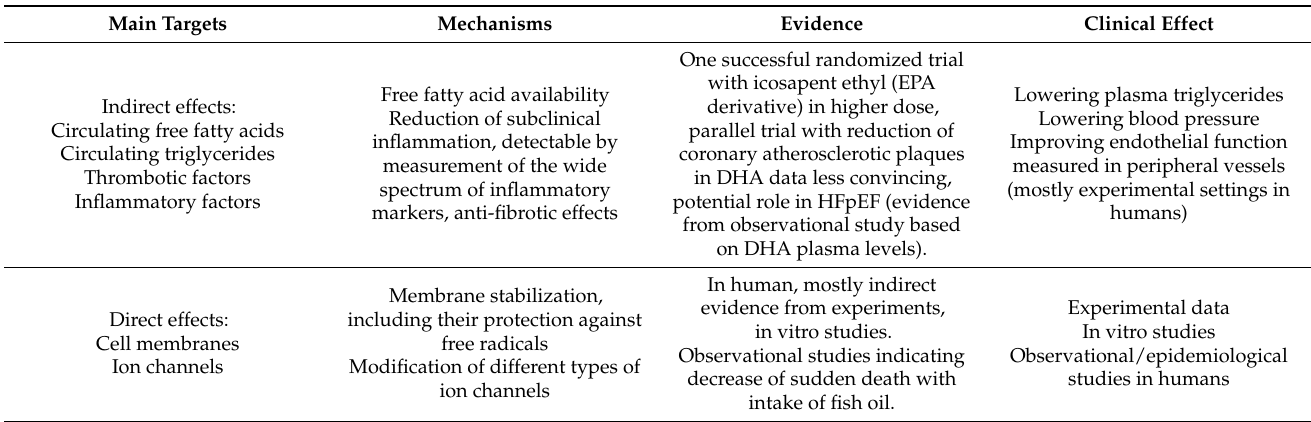
Table 2. Potential effects of omega-3 fatty acids on cardiovascular